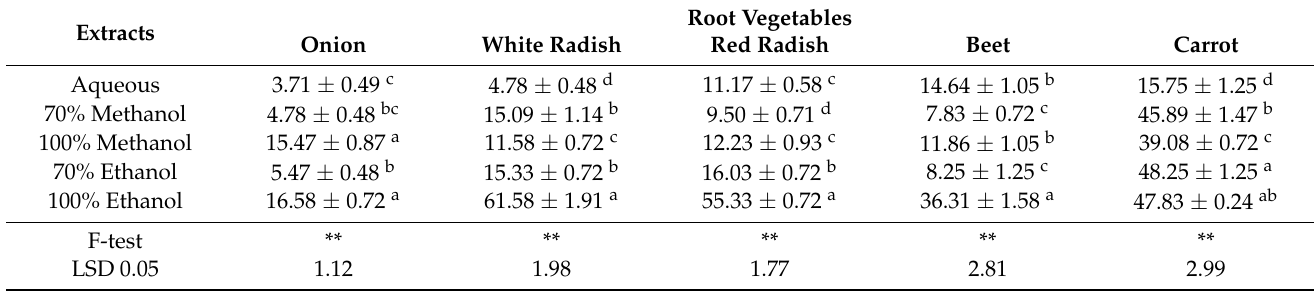
Table 5. Total flavonoid content (mg CE/g) of the aerial part of selected root vegetables. Root Vegetables Extracts Onion White Radish Red Radish Beet